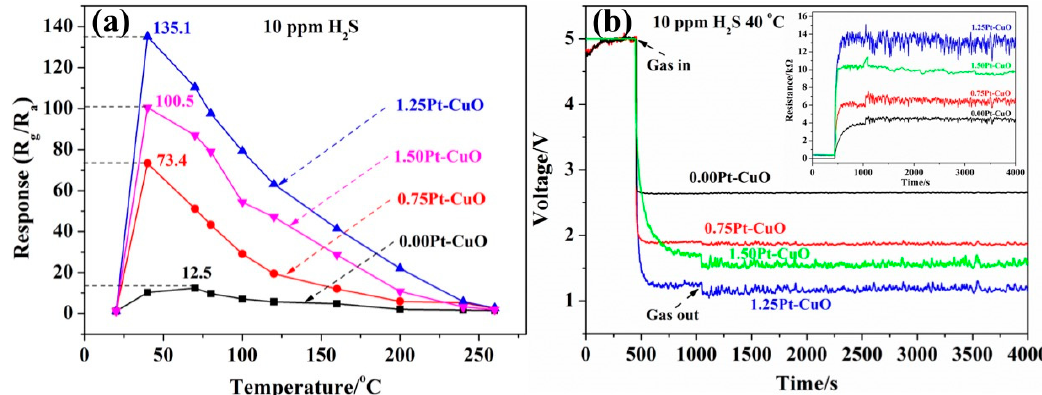
Figure 7. ( a ) Response of 0.00Pt-CuO, 0.75Pt-CuO, 1.25Pt-CuO, and 1.50Pt-CuO sensors to 10 ppm H 2 S as a function of operating temperature; ( b ) the corresponding sensing transients of 0.00Pt-CuO, 0.75Pt-CuO, 1.25Pt-CuO, and 1.50Pt-CuO sensors to 10 ppm H 2 S at 40 °C. The inset of ( b ) is the resistance variation of four sensors to 10 ppm H 2 S at 40 °C.